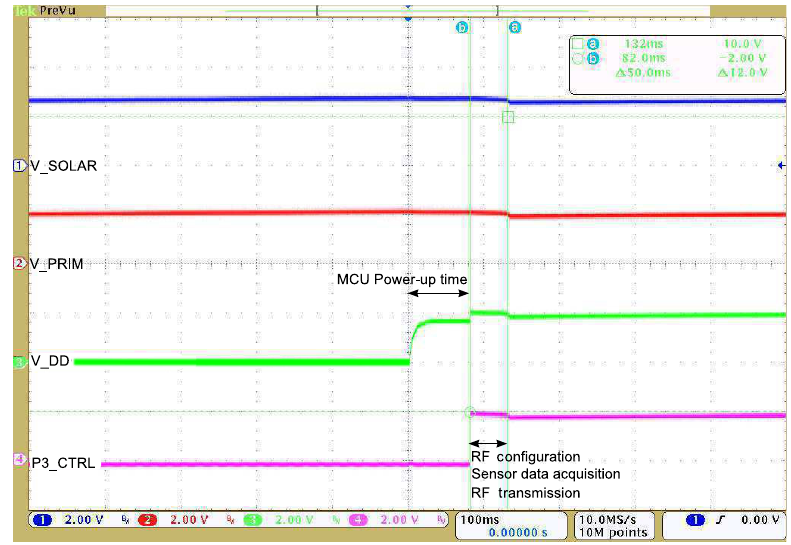
Figure 7. System start-up and one active period at illumination level of 1000lx (office environment under daylight). Waveforms are acquired at points denoted in Figure